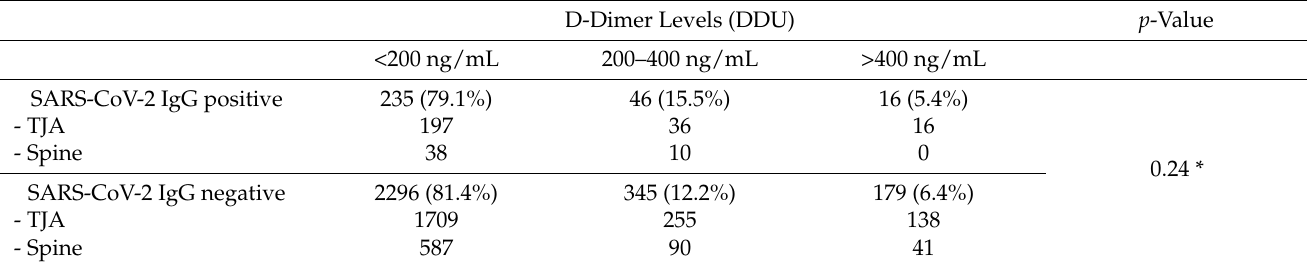
Table 2. Distribution of D-Dimer levels of SARS-CoV-2 IgG positive and negative patients. D-Dimer Levels (DDU) p -Value <200 ng/mL 200–400 ng/mL >400 ng/mL SARS-CoV-2 IgG